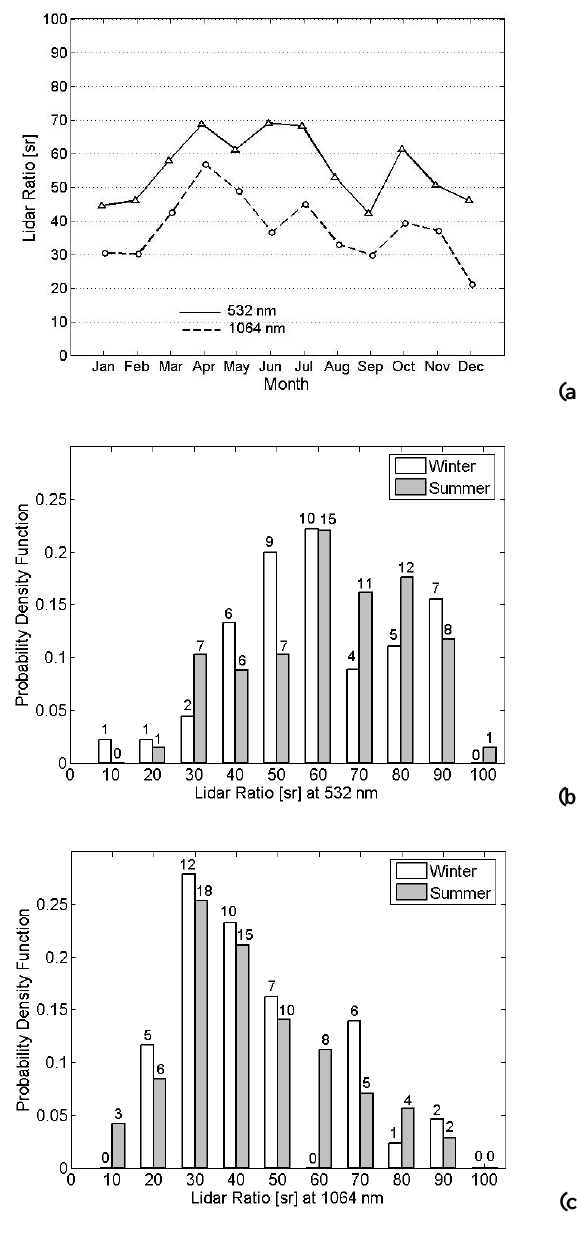
Fig. 4. Lidar-derived daytime lidar ratio: (a) Annual cycle; probability density functions at (b) 532 and (c) 1064 nm. The numbers above the bars indicate the number of observation days.